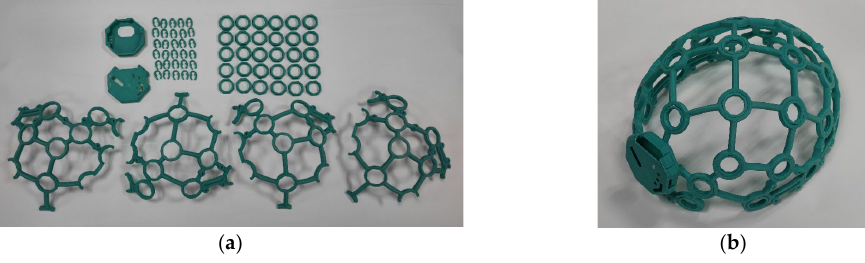
Figure 2. 3D printed headwear. ( a ) Printed parts; ( b ) assembled headwear.